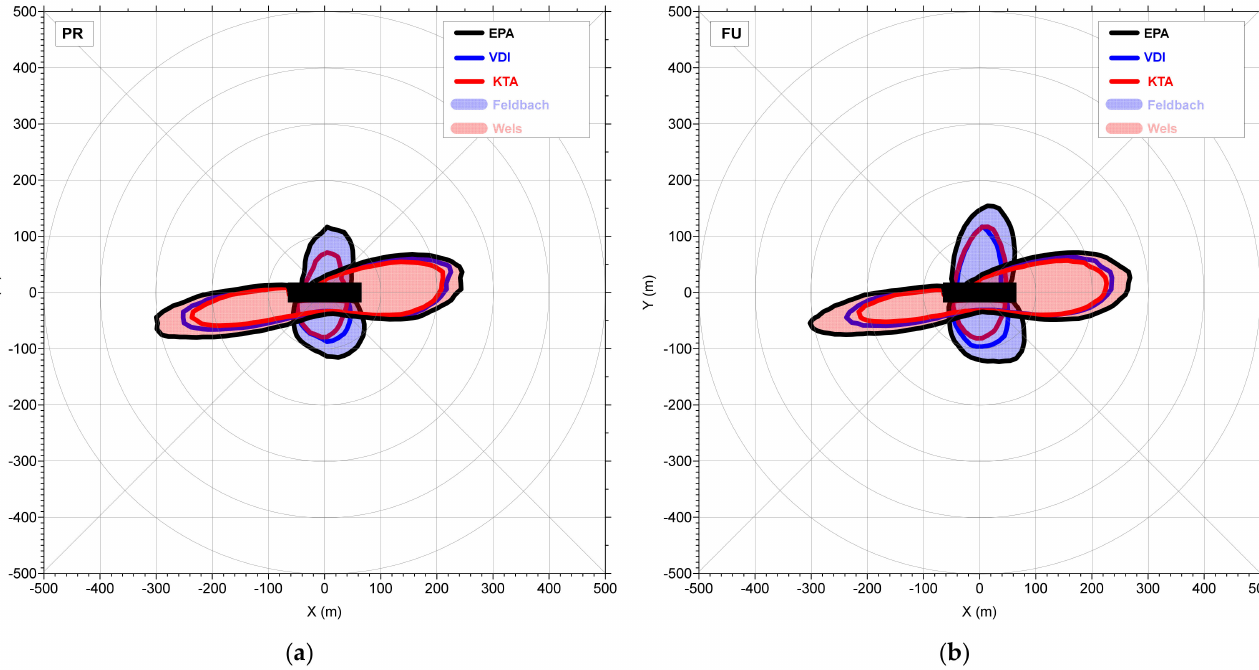
Figure 9. Direction-dependent separation distances (m) for 15% exceedance probability (commercial/industrial and agriculturally dominated areas) at Feldbach and Wels, ( a ) for PR (present climate (1981–2010)) and ( b ) FU (future climate (2036–2065)); based on a combination of global radiation and the vertical temperature gradient (EPA), cloudiness (VDI) and radiation balance (KTA), each in combination with wind speed, to determine stability classes; the black rectangle is the livestock